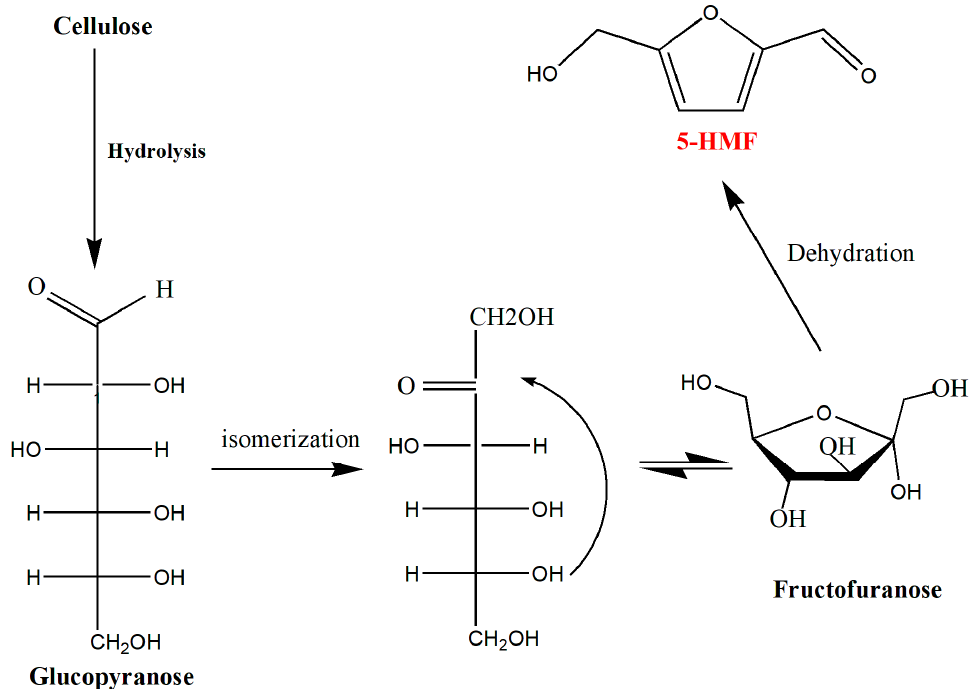
Figure 7. Pathways for cellulose transformation to 5-hydroxyfurfural (5-HMF) (Resketched from reference [12]).